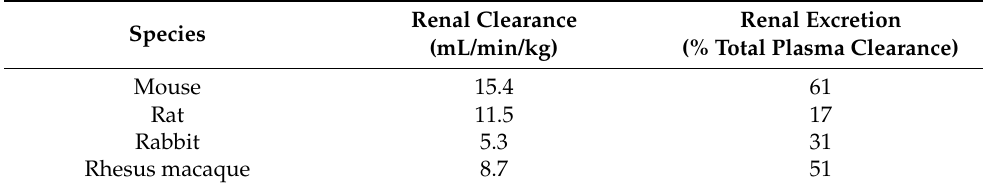
Table 1. Renal clearance and excretion in nonclinical species.